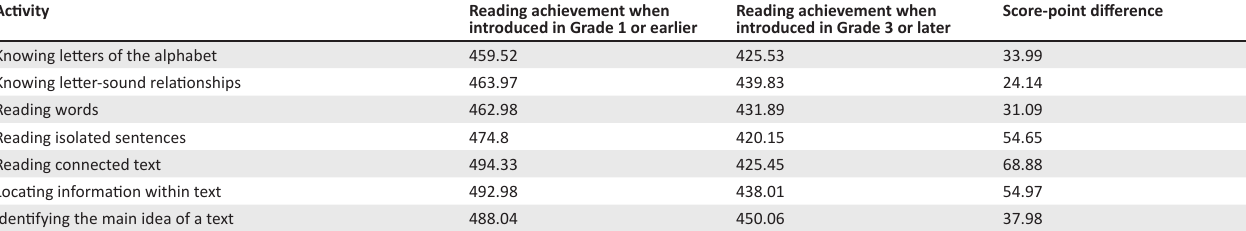
TABLE 5: Score-point differences based on when skills are introduced. Activity